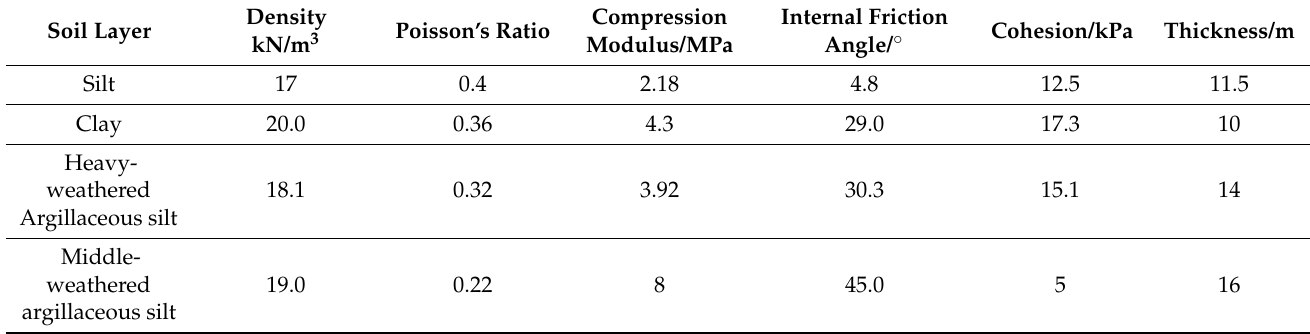
Table 1. Physical and mechanical parameters of soil